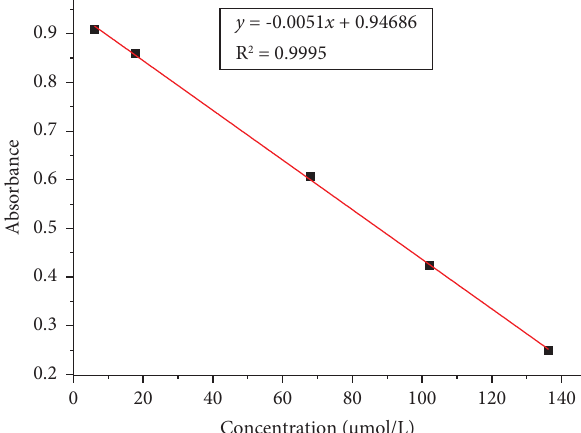
Figure 1: Te calibration curve of ascorbic acid standard DPPH scavenging